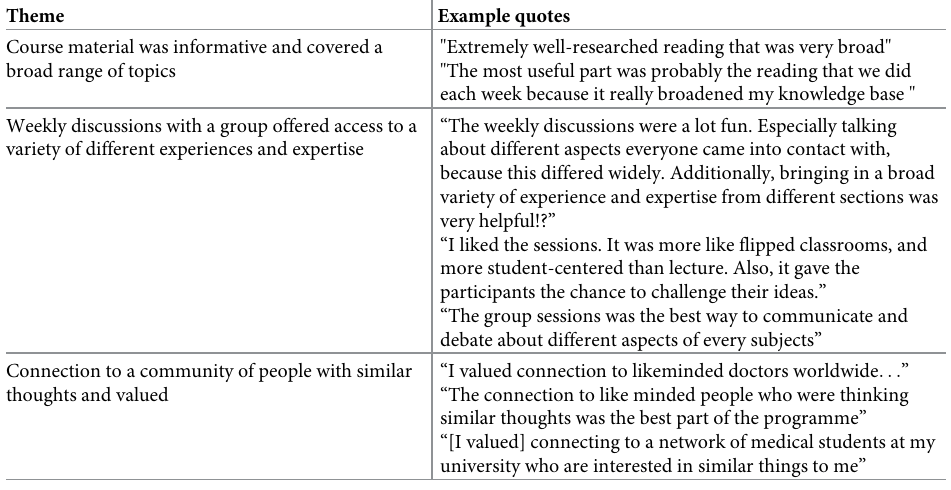
Table 3. Areas of the fellowship that the participants found most